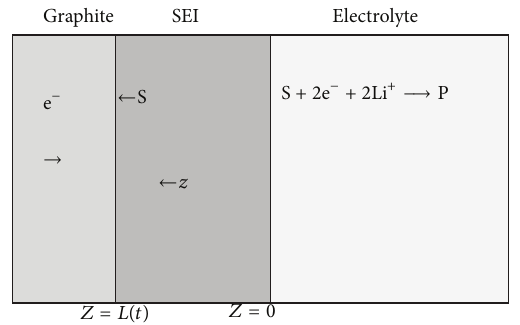
Figure 1: Schematic of film growth on the anode surface in a lithium ion battery. The solvent reacts with the lithium at the electrode/film interface to form the lithium carbonate